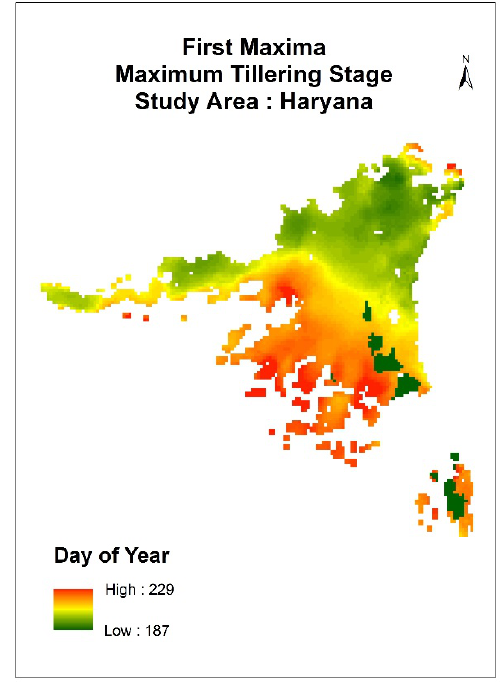
Figure 4: Maximum Tillering Stage of Rice for Haryana The number of days of Transition from max tillering to heading is shown in figures 7 & 8 for Punjab and Haryana